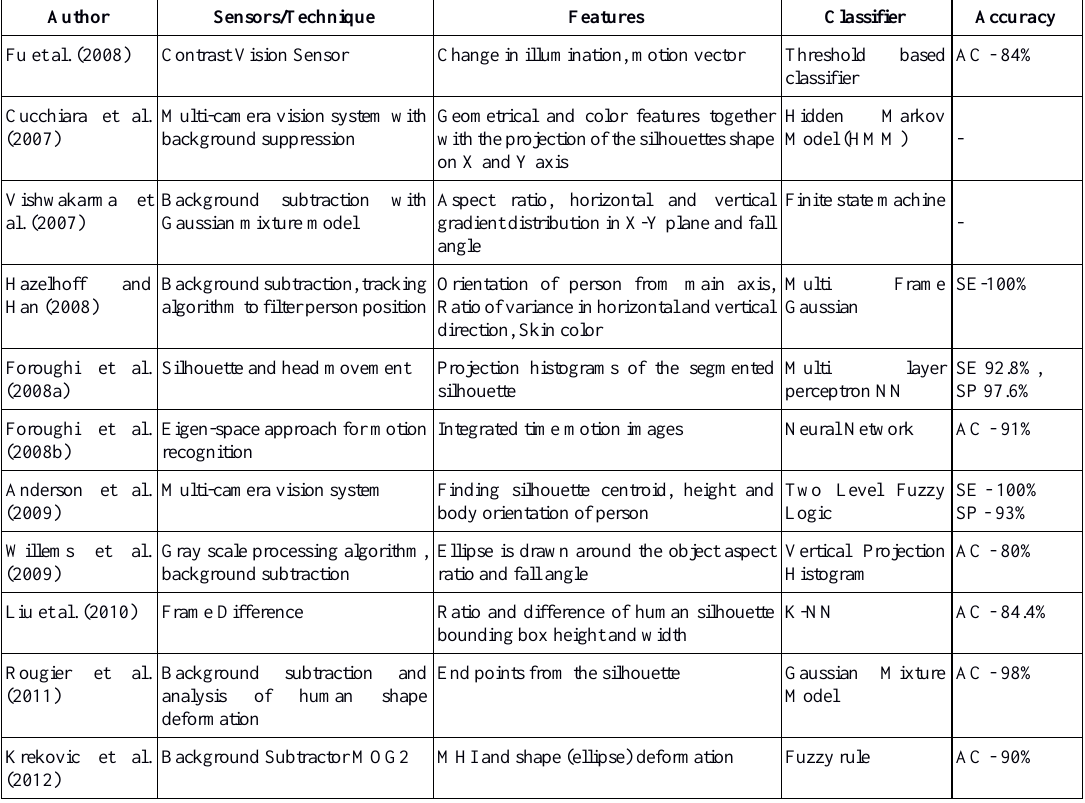
Table 4. Vision-based fall detection systems